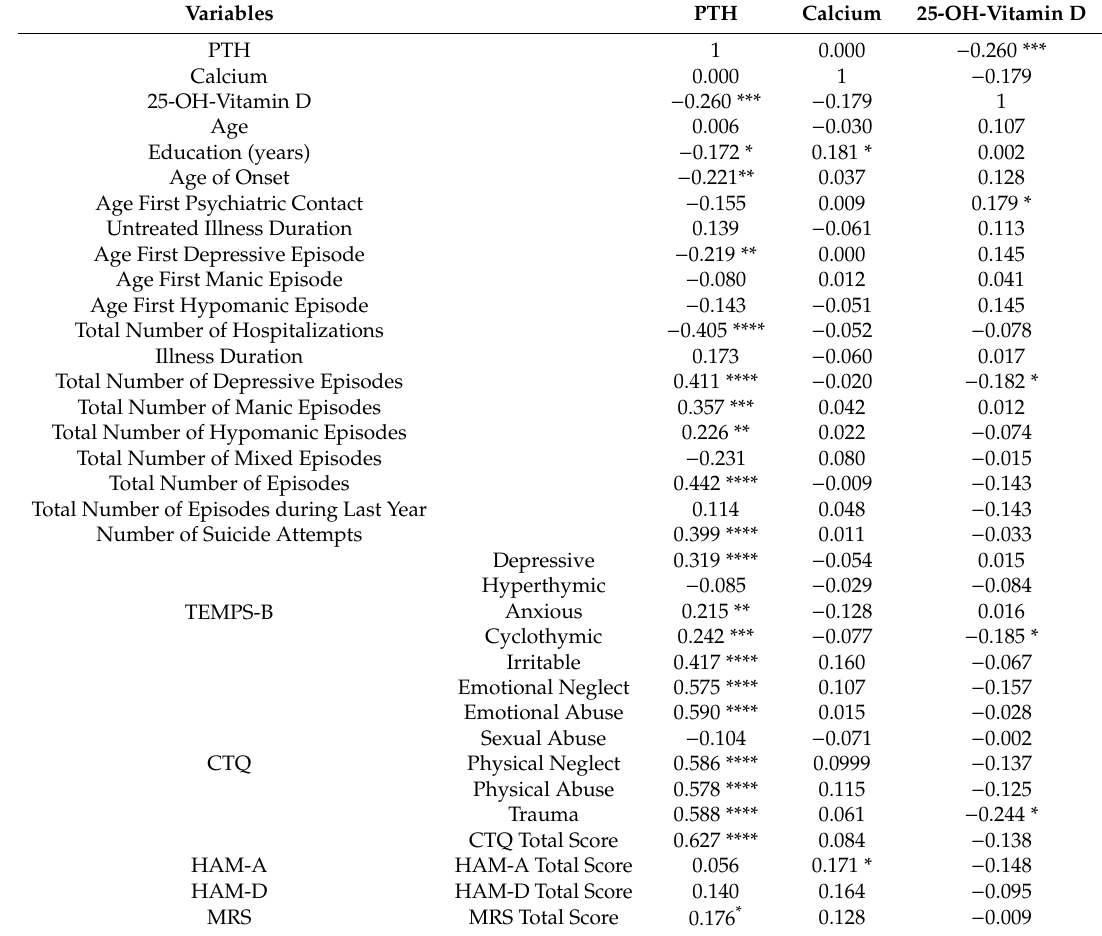
Table 3. Pearson rho correlations of clinical variables and psychopathological